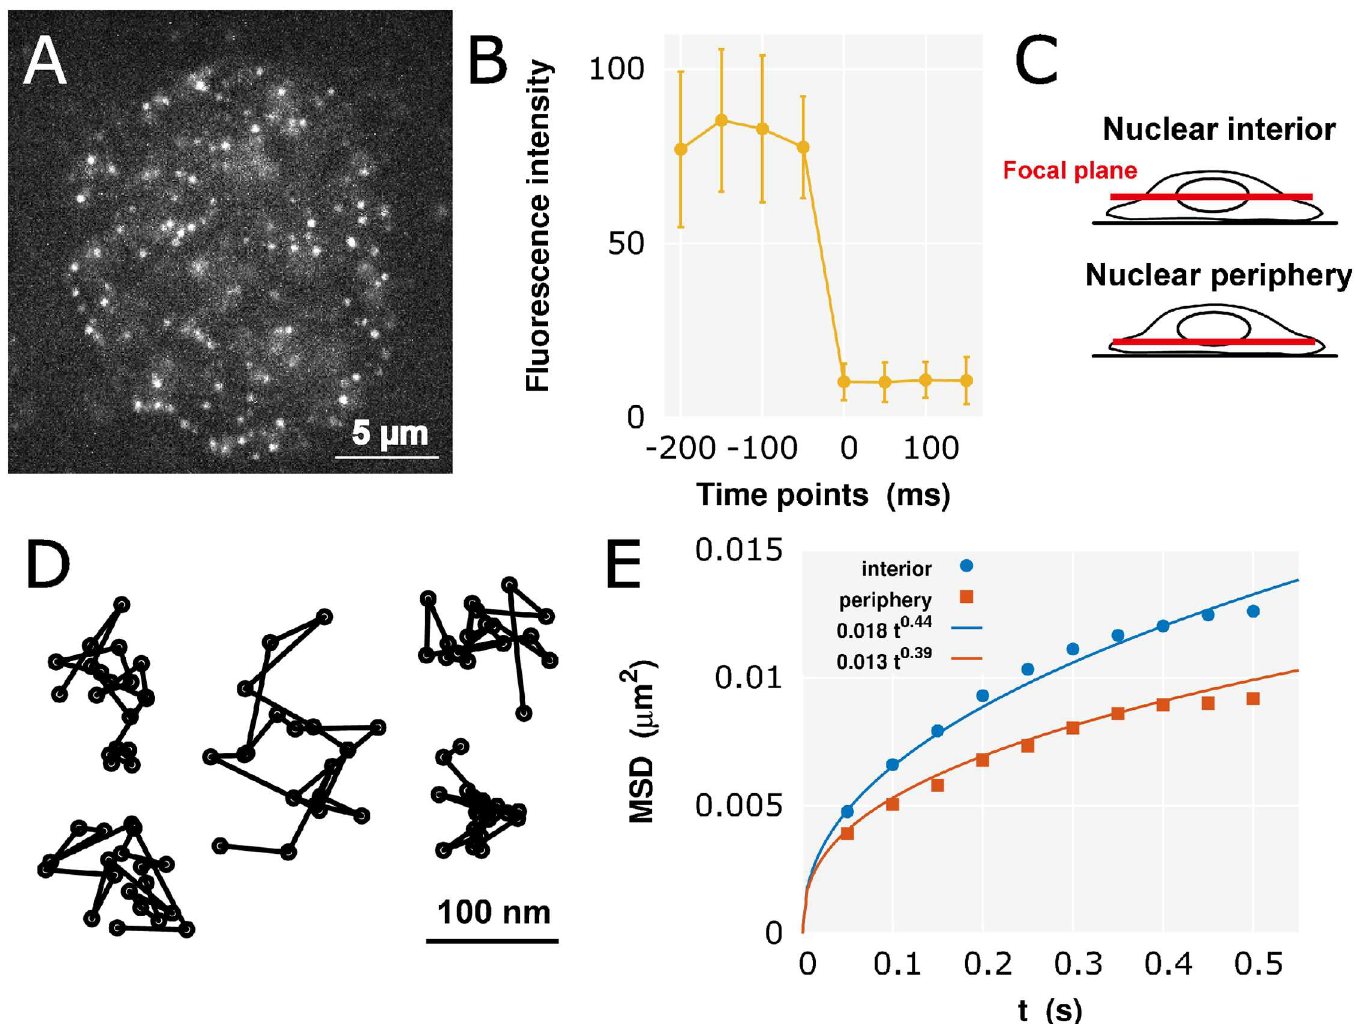
Fig 2. Single-nucleosome imaging and analysis. (A) Single-nucleosome image of a human HeLa cell nucleus expressingH2B-PA-mCherry. Each dot represents single nucleosome. (B) Evidence that each dot represents single-nucleosome molecule. Each H2B-PA-mCherry dot shows single-step photobleaching. The vertical axis represents the fluorescence intensity of each H2B-PA-mCherry dot. The horizontalaxis is the tracking time series (each photobleaching point is set as time 0; the average and the standard deviationat each time point were calculated for 50 dots.). Due to the clear single-step photobleaching profile of the H2B-PA-mCherry dots, each dot shows a single H2B-PA-mCherry moleculein a single nucleosome. (C) A scheme for nuclear interior (Top) and periphery (Bottom) imaging. Focal plane (red) in the living cells is shown. See also S1 Fig. (D) Representative trajectories of fluorescently labeledsingle nucleosome (50 ms per frame). (E) Plots of the MSD at the interior and peripheryregions. These fit well with the MSD curves using Eq 1.